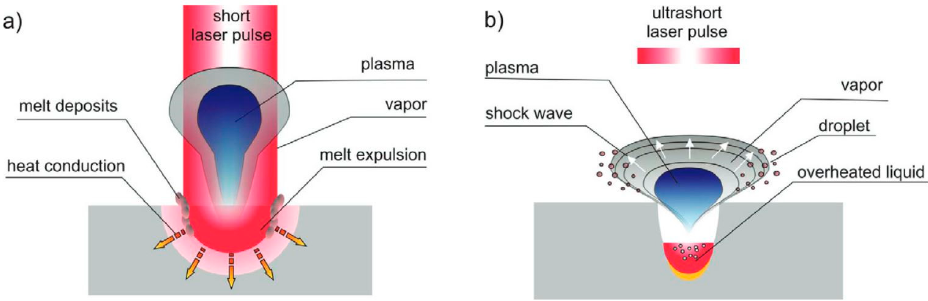
Figure 1. Pulsed laser beam and matter interaction ( a ) short pulse laser ( μ s, ns)—matter interaction; ( b ) ultrashort pulse (ps, fs) beam ‐ matter interaction [22]. ( b ) ultrashort pulse (ps, fs) beam-matter interaction